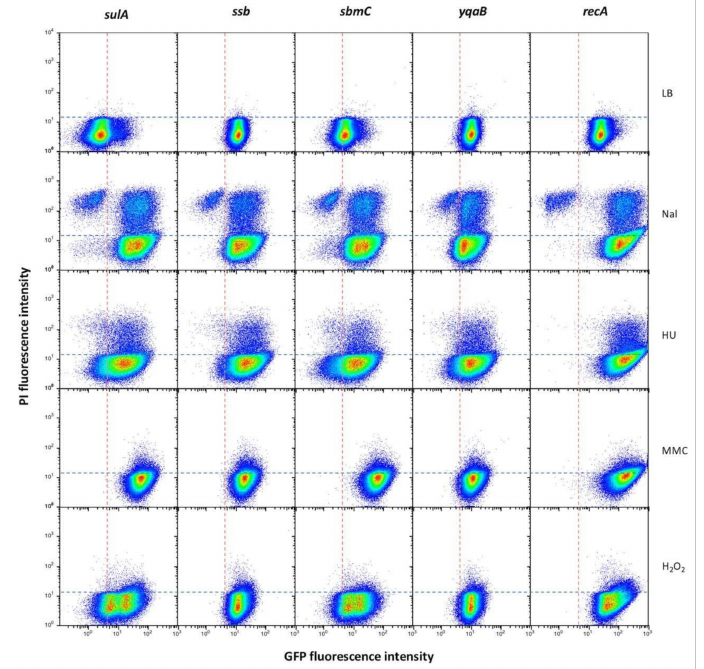
Figure 7. Expression patterns of genes belonging to groups I ( sulA ), II ( ssb ), III ( sbmC ) and miscel- laneous ( yqaB and recA) upon SOS induction. The DNA damaging agents used were nalidixic acid (Nal), hydroxyurea (HU), mitomycin C (MMC) and hydrogen peroxide. The vertical division sorts OFF (GFP − , left) and ON (GFP + , right) subpopulations. The horizontal division sorts live (PI − , bottom) and dead (PI + , top) subpopulations.